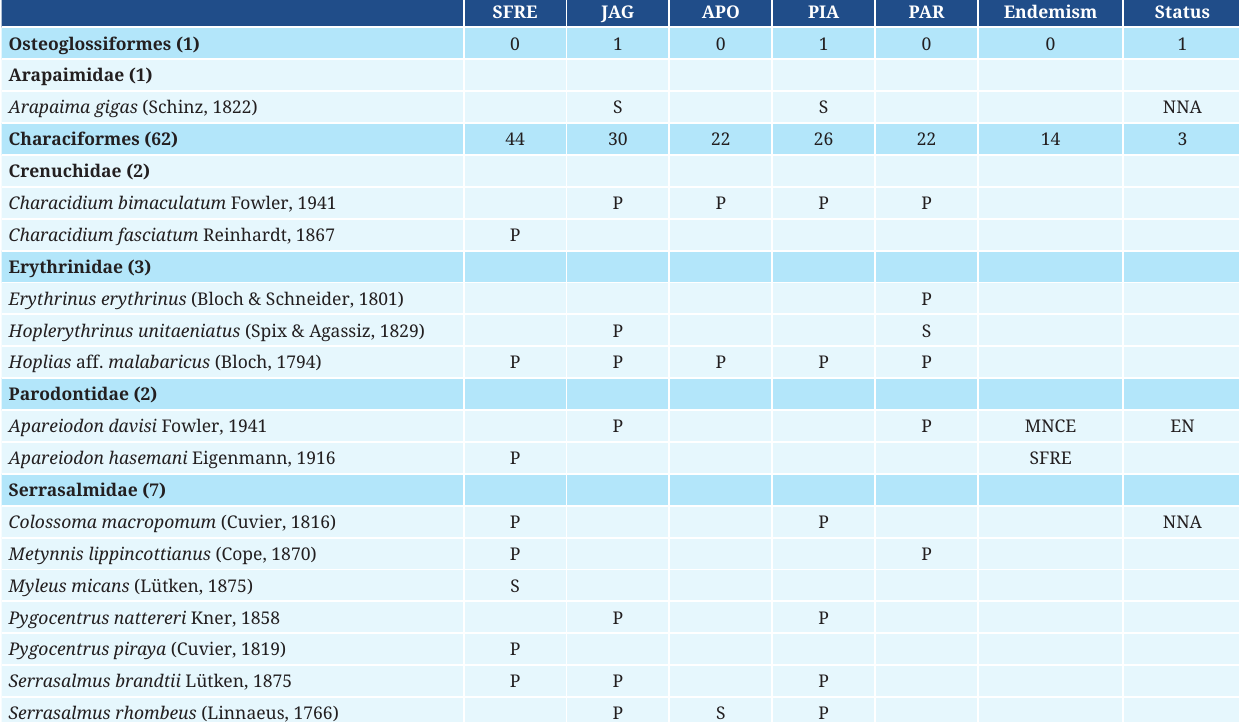
TABLE 1 | List of freshwater fish species recorded in the São Francisco Interbasin Water Transfer Project basins in the Brazilian semiarid. SFRE = São Francisco Ecoregion (lower-middle São Francisco basin); MNCE = Mid-Northeastern Caatinga Ecoregion; JAG = Jaguaribe basin; APO = Apodi-Mossoró basin; PIA = Piranhas-Açu basin; PAR = Paraíba do Norte basin; P = Primary data; S = Secondary data; NNA = Non- Native Species; EN = Endangered; VU = Vulnerable; CR = Critically Endangered. Fish classification follows Fricke et al.